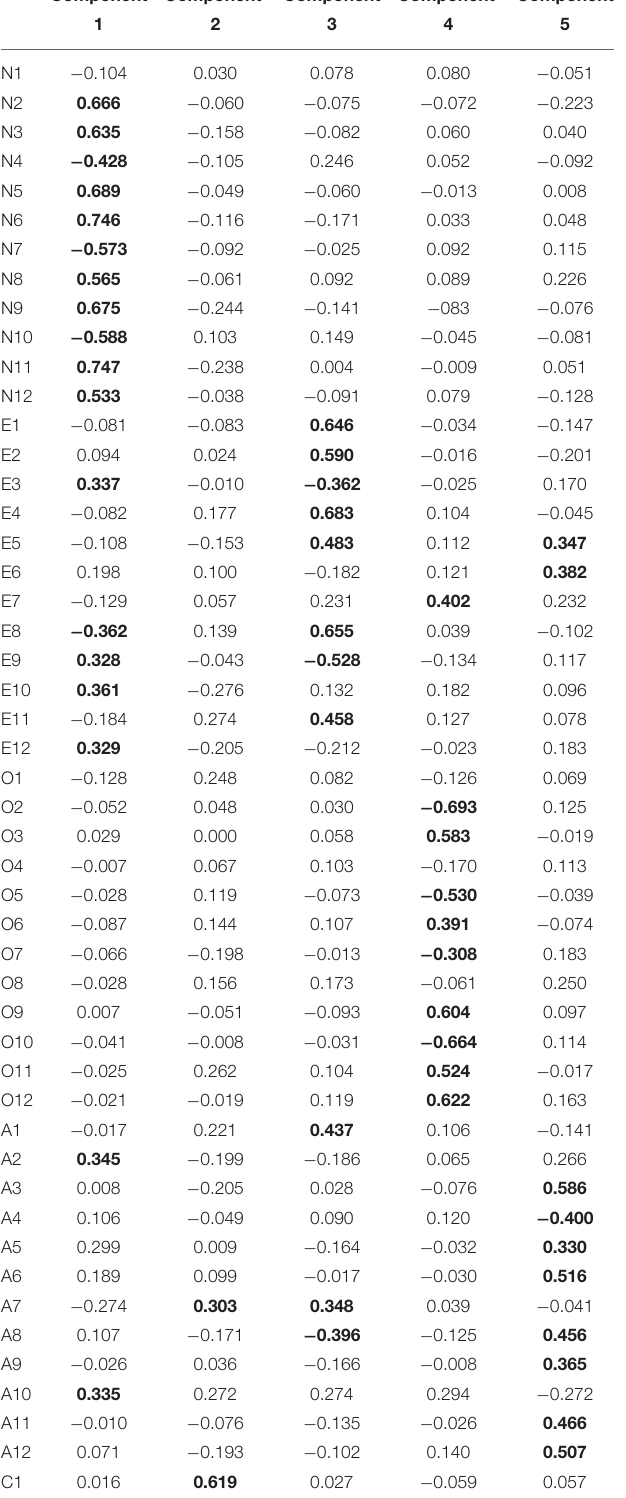
TABLE 6 | Component-analysis of the first five (orthogonal) varimax factors extracted from analysis of the NEO-FFI ( n = 378). Component Component Component Component